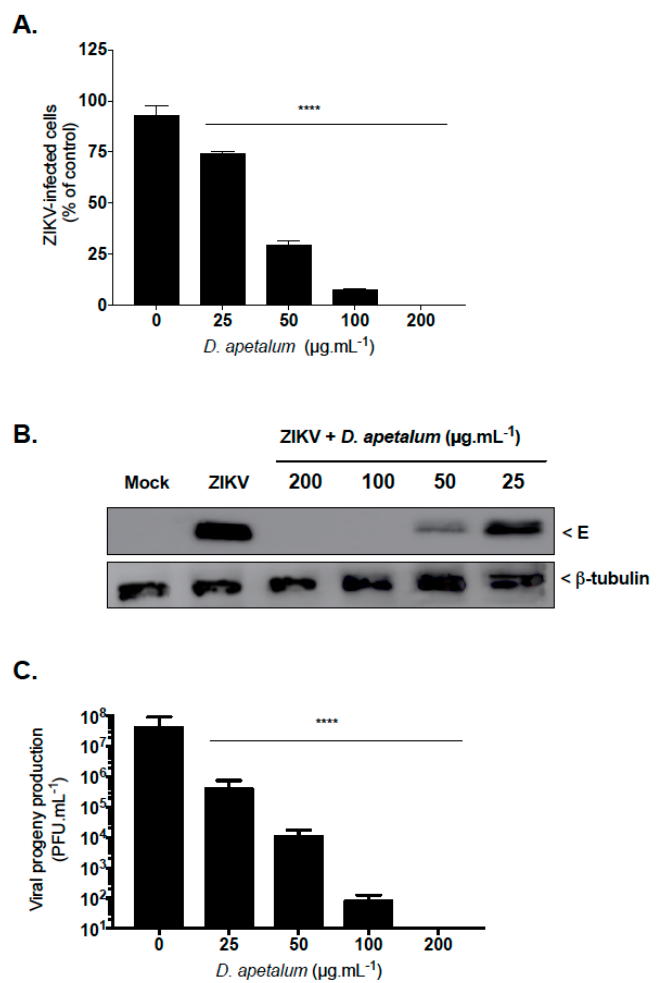
Figure 2. D. apetalum extract prevents infection of A549 cells by epidemic strain of Zika virus (ZIKV). A549 cells wer e infected with PF-25013-18 at a multiplicity of infection (MOI) of 2 and continuously incubated with different non-cytotoxic concentrations of D. apetalum extract. ( A ) Immunofluorescence analysis of viral protein expression in ZIKV-infected A549 cells. ( B ) Detection of intracellular E protein in ZIKV-infected A549 cells by immunoblot assay using anti-E mAb. β -tubulin served as loading control. ( C ) ZIKV progeny production was quantified by plaque-forming assay. Data represent the means ± SD from four independent experiments. One-way ANOVA and Dunnett’s test were used for statistical analysis (**** p < 0.0001).